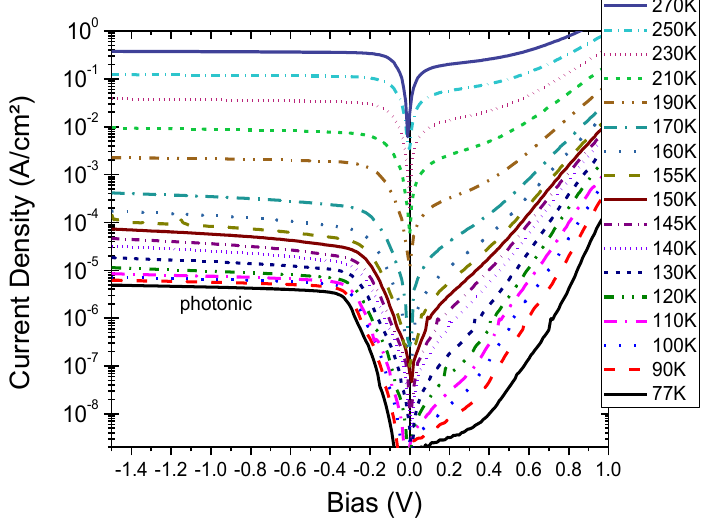
Figure 10. Dark current density-voltage (J-V) characteristics of a Ga-free T2SL nBn MWIR detector for temperatures from 77 to 270 K.